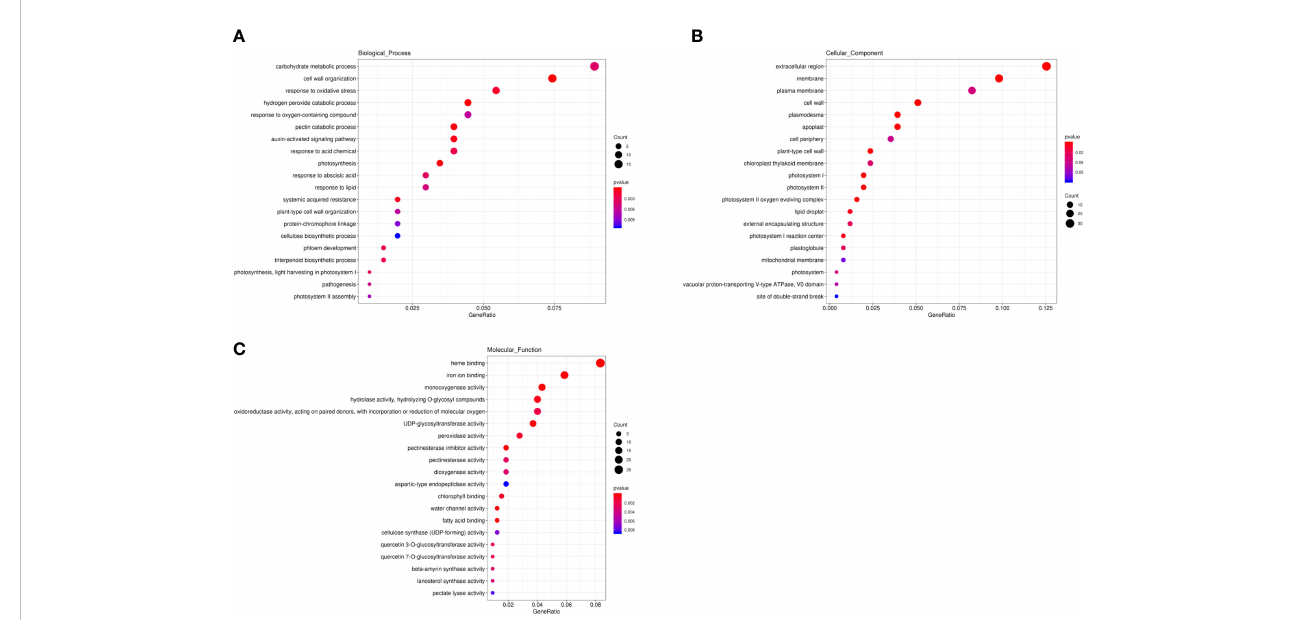
FIGURE 6 Functional enrichment analysis of DEGs. (A) Bar plot of GO terms involved in biological processes. (B) Bar plot of GO terms associated with cellular components. (C) Bar plot of GO terms involved in molecular